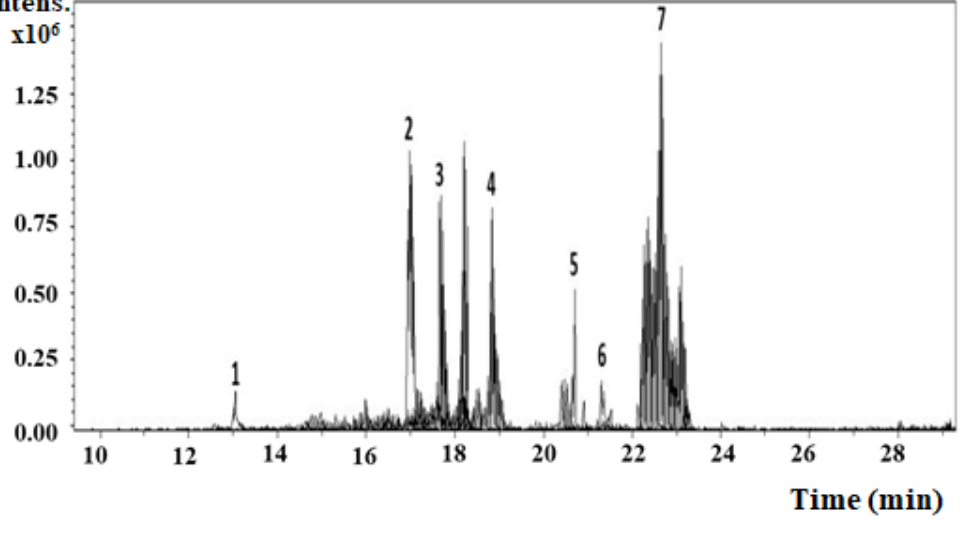
Figure 1. The extracted ions chromatogram of the identified compounds using ESI-Ve ionization mode in tandem mass spectrometry. Table 1. Compounds identified from A. fruticosus and their HPLC–MS/MS 2 data using ESI-Ve ion- ization.